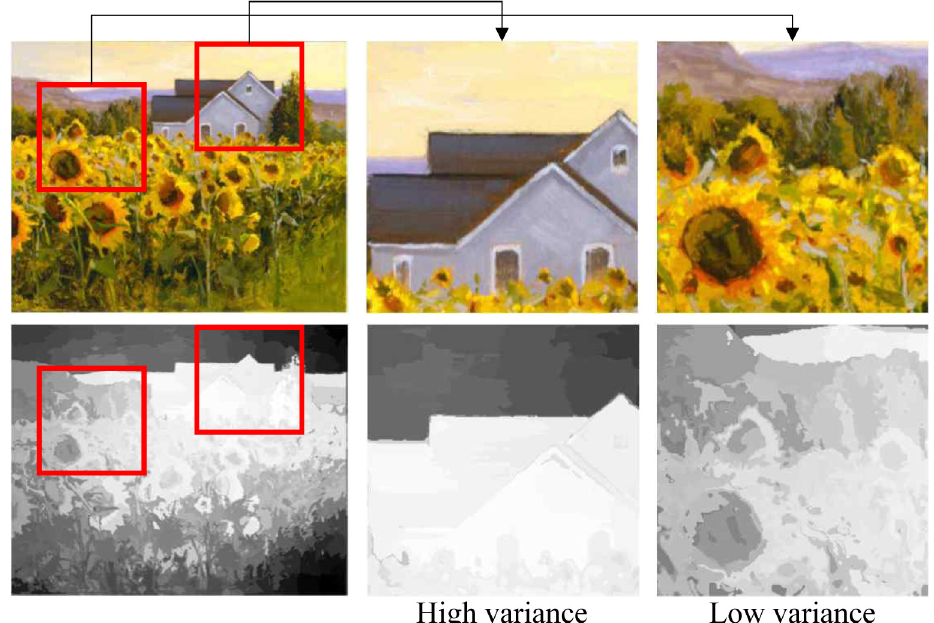
Figure 10. Examples of patches with identical saliency scores (0.67) but different variance values (0.16 and 0.33, respectively). The patch with high variance has a smaller probability of containing MTS than a patch with low